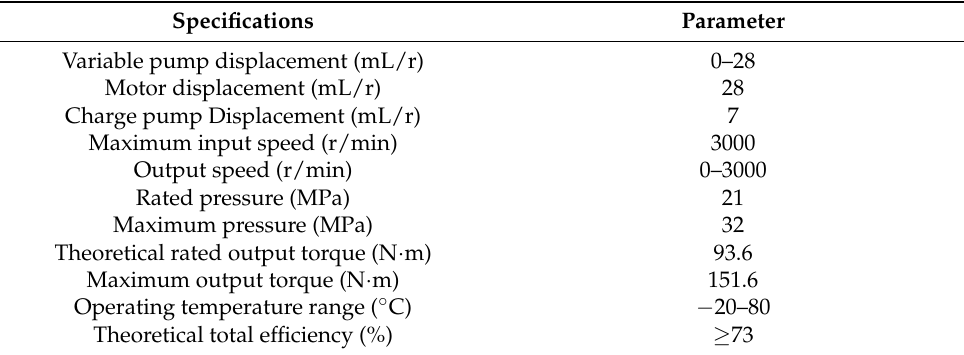
Table 5. Main parameters of the LY-HPVMF-28-L-02 type HST.